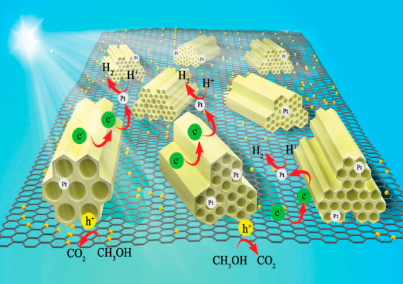
Figure 3. Schematic illustration of the transfer of photoexcited electrons and production of H 2 photocatalyzed by MNb–N-doped graphene (NGR) under visible light. Reproduced with permission from the authors of [28]. Copyright (2019), The Royal Society of Chemistry, London, United